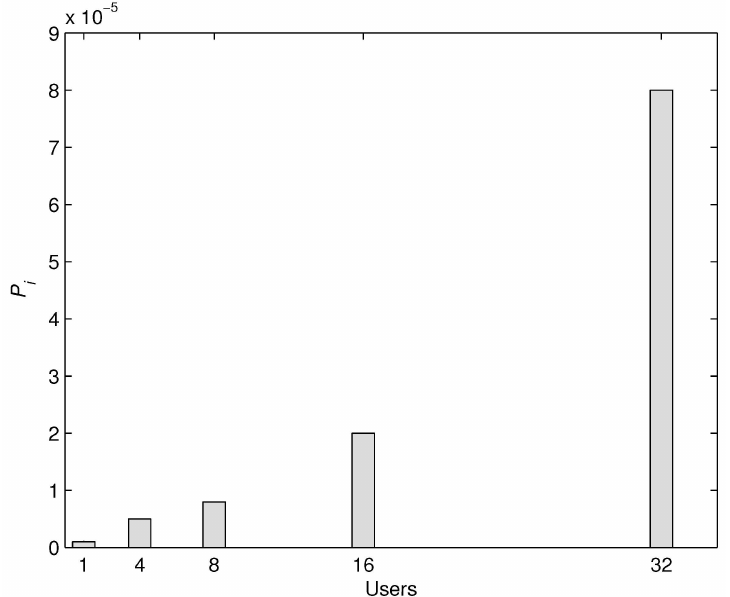
Figure 6. The impact of increasing the number of users on the proposed identifier. The system’s parameters are U = 4, N = 2048, (cid:104) Φ ( u ) (cid:105) = 512, u = 0,1,2,3, ν = 11, χ = 60, 10 channel paths; convolutional codes of rate 0.5; interleaved sub-carrier mapping; an STBC set of S1, S2, S3, S4, S5; and a modulation set of 4-QAM, 16-QAM, 64-QAM, 128-QAM, 256-QAM, and